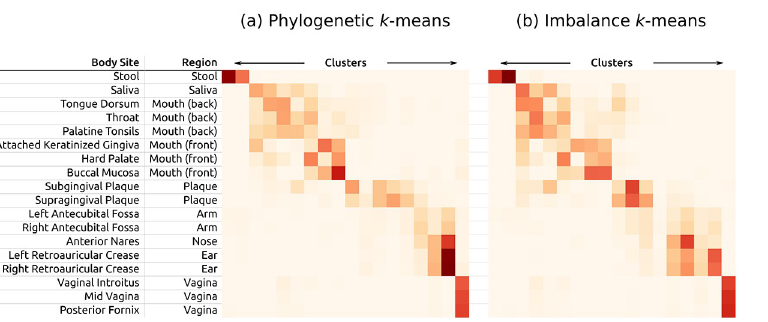
Fig 9. k -means cluster assignments of the HMP dataset with k ≔ 18. Here, we show the cluster assignments as yielded by Phylogenetic k -means (a) and Imbalance k -means (b) of the Human Microbiome Project (HMP) dataset. We used k ≔ 18, which is the number of body site labels in the dataset, in order to compare the clusterings to this “ground truth”. Each row represents a body site; each column one of the 18 clusters found by the algorithm. The color values indicate how many samples of a body site were assigned to each cluster. Similar body sites are clearly grouped together in coherent blocks, indicated by darker colors. For example, the stool samples were split into two clusters (topmost row), while the three vaginal sites were all put into one cluster (rightmost column). However, the algorithm cannot always distinguish between nearby sites, as can be seen from the fuzziness of the clusters of oral samples. This might be caused by our broad reference tree, and could potentially be resolved by using a tree more specialized for the data/region (not tested). Lastly, the figure also lists how the body site labels were aggregated into regions as used in S9 Fig. Although the plots of the two k -means variants generally exhibit similar characteristics, there are some differences. For example, the samples from the body surface (ear, nose, arm) form two relatively dense clusters (columns) in (a), whereas those sites are spread across four of five clusters in (b). On the other hand, the mouth samples are more densely clustered in